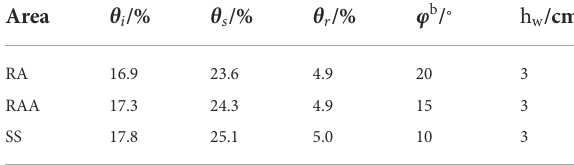
TABLE 1 Parameter values of analytical solution of